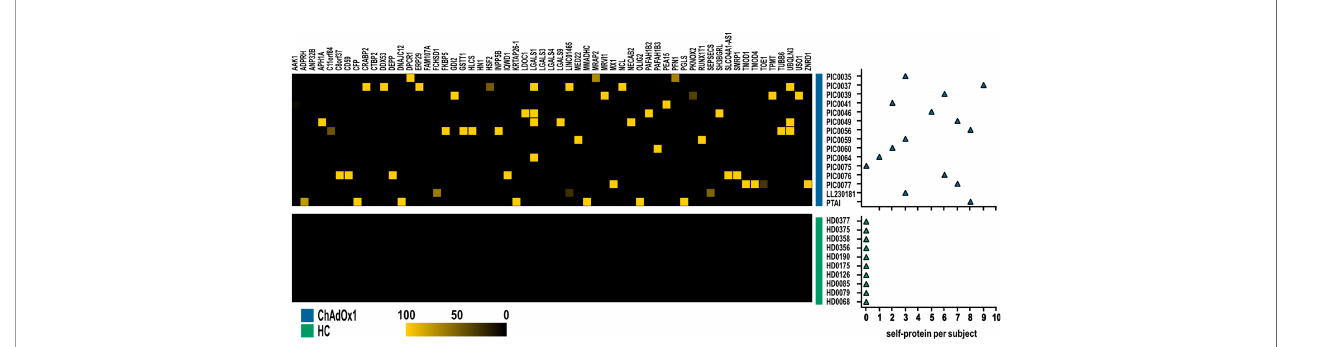
FIGURE 4 | Autoantigens speci fi cally recognized by at least one subject in ChAdOx1 group as opposed to HC. Heatmap depicting IgG reactivities of ChAdOx1vaccinated subject ( n = 15, in blue) collected post-vaccination, and healthy donors (HC; n = 10, in green), arranged in rows, for the 59 antigens (in column). Yellow indicates positive immune reactivity (>30 ng/ m l), and black indicates low or no immune-reactivity (<30 ng/ m l). The count of the self-proteins recognized by ChAdOx1 vaccinated subjects and HC (blue and green, respectively) is shown in the right panel. Counts were based on antibodies that were present at levels ≥ 30 ng/